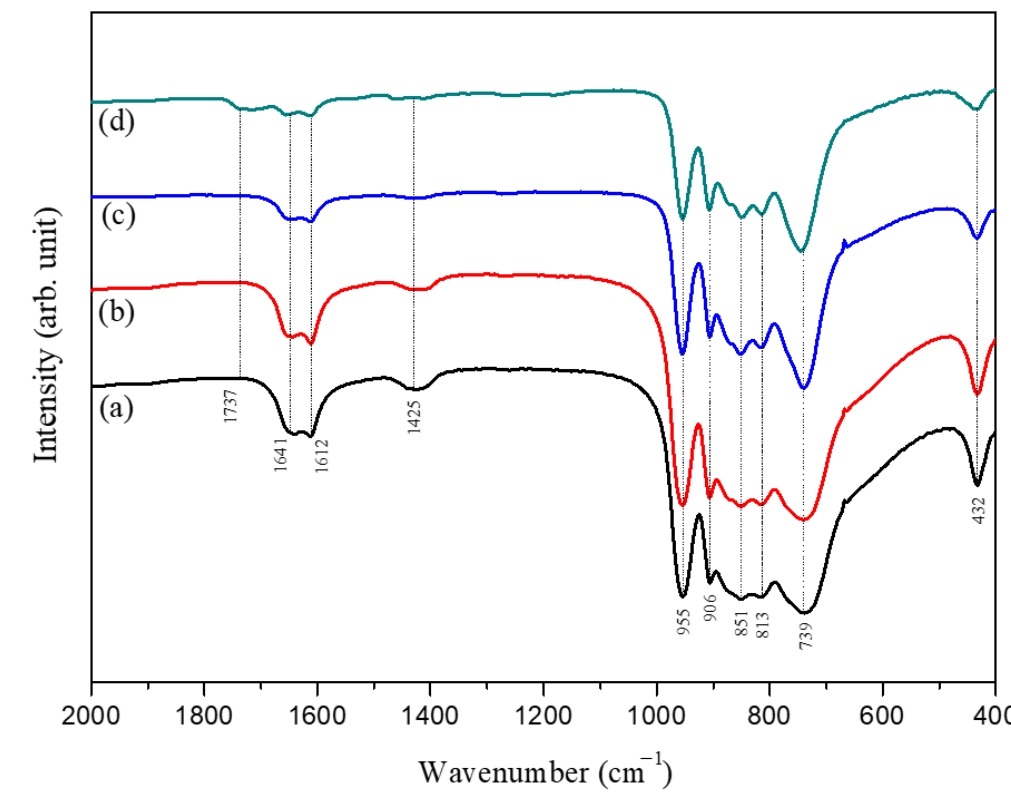
Figure 2. Fourier Transformed Infrared (FTIR) spectra for ( a ) CoMoO 4 · nH 2 O pure and Co 1 − x Cu x MoO 4 · nH 2 O with x equals to ( b ) 0.03, ( c ) 0.06, and ( d ) 0.12.